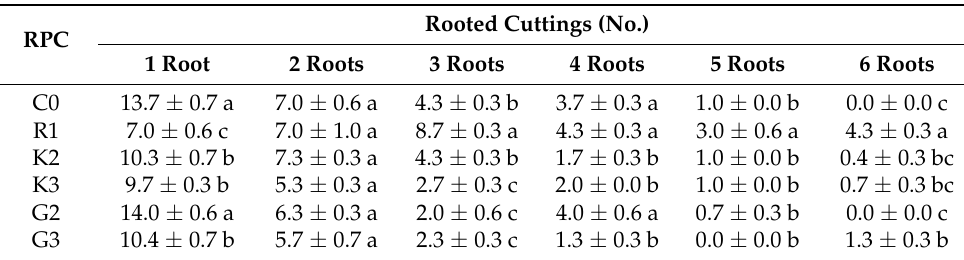
In columns, different letters indicate significant differences within parameters (S.N.K. test, p ≤ 0.05; mean ± SD, n = 3) C0: untreated control; R1: Rhizopon AA (1% IBA); K: Kelpak ® ; G: Goteo ® ; K2: 2 mL L − 1 ; K3: 3 mL L − 1 ;